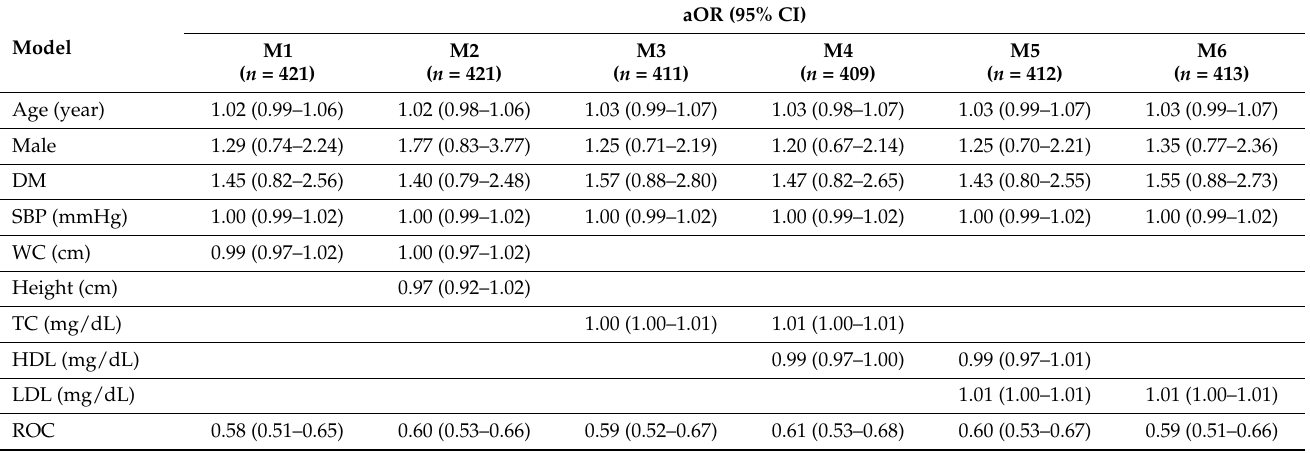
Table 2. Prediction models for MCI regarding variables from